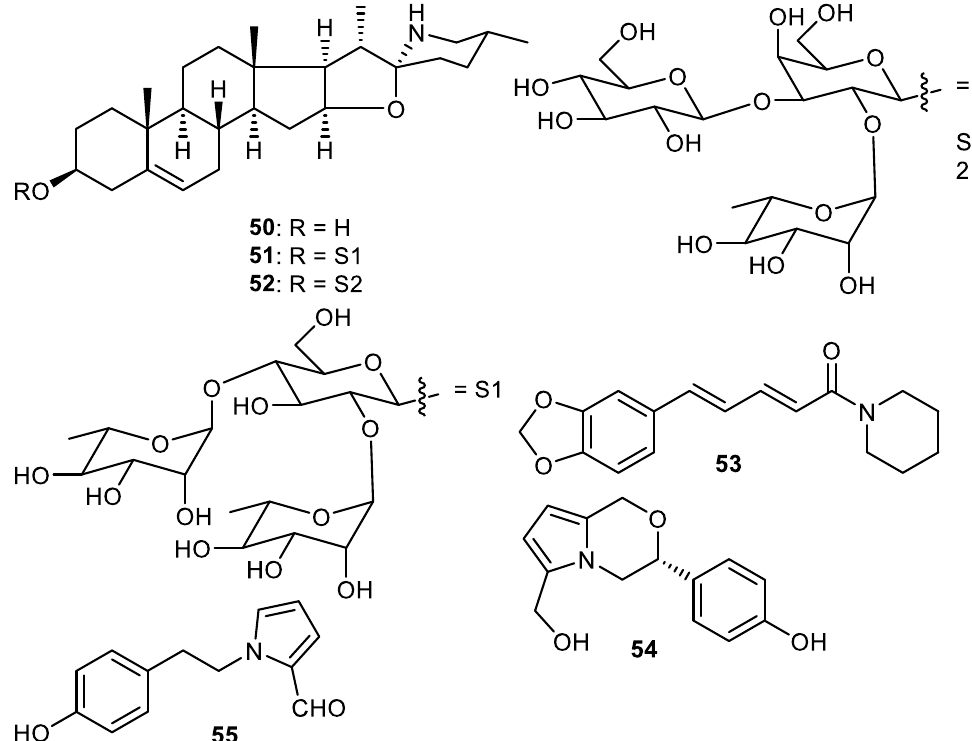
Figure 8. Structures of alkaloids 34 – 39 .